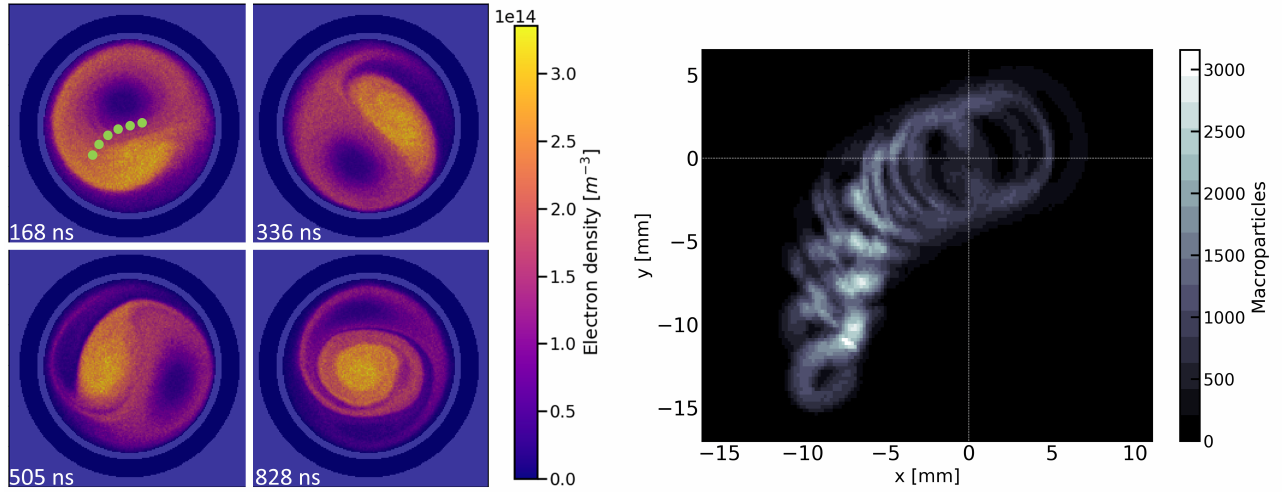
Figure 12. PIC [61] simulation of a plasma instability that was observed to focus the proton pencil beams into rings. Left : the averaged density of plasma in a transverse cross-section through the lens at four different time steps during the evolution of the instability. The green spots mark the entry position of the pencil beams. Right : number of macroparticles hitting a screen 67cm downstream of the